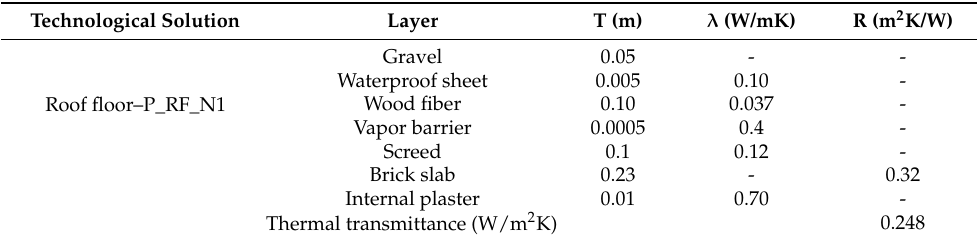
Table A12. Possible redevelopment measure for roof floor with gravel as the finishing layer (P_RF_N1).